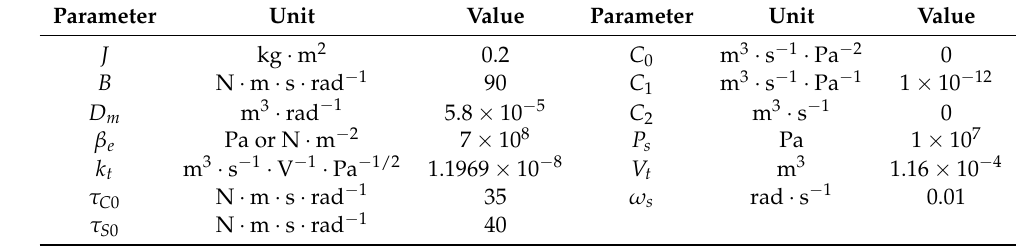
Table 1. System parameters of the studied EHSS.